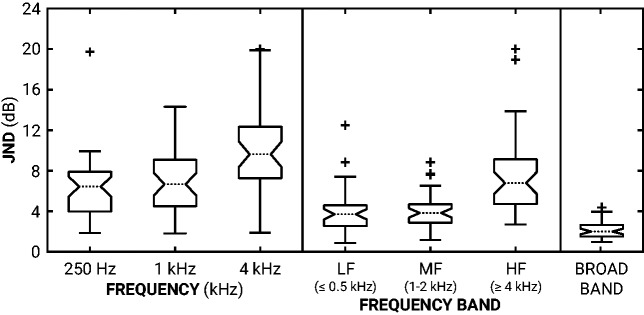
Box plot of JNDs. The left panel shows the octave-band JNDs, the middle panel shows the dual-band JNDs (LF, MF, and HF refer to low-, mid-, and high-frequency dual-octave-bands, respectively) and the right panel shows the broadband JNDs. Notches on each interquartile range (box) show the 95% confidence interval around the median. Whiskers encompass JNDs within 1.5 × interquartile range. Pluses indicate outliers with JNDs > or < 1.5 × interquartile range. JND = just-noticeable difference; LF = low frequency; MF = mid frequency; HF = shigh frequency.